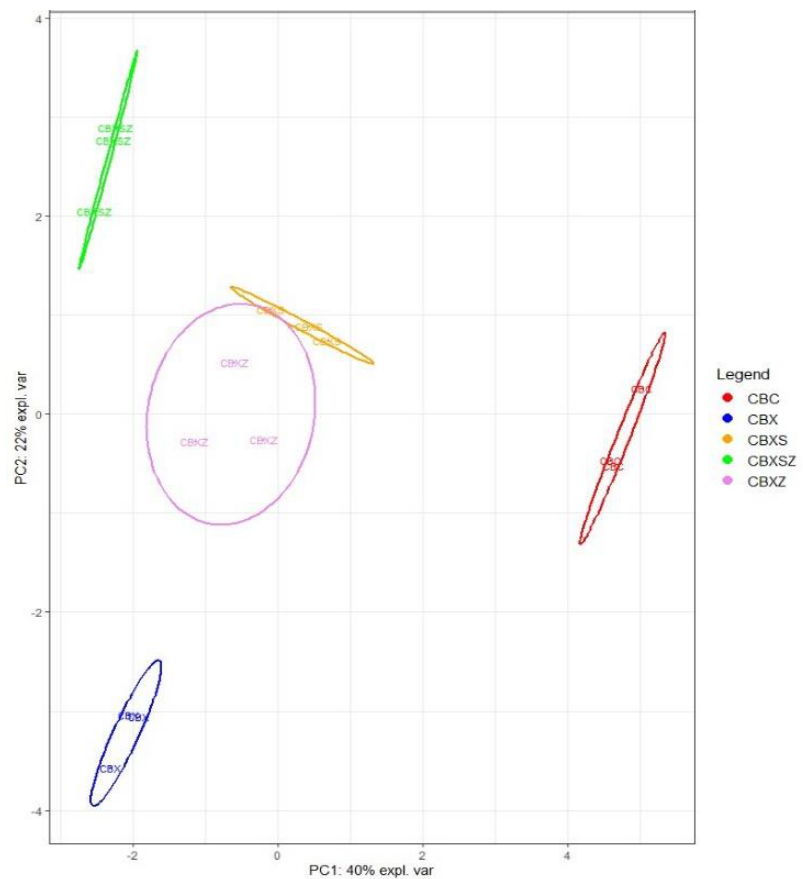
Figure 10. Principal component analysis (PCA) biplot with ellipses (confidence interval of 0.95) showing the effect of S. montana EO, EO-Zein NP nanoformulation and empty zein NPs on infected tomato plants. PC1 (first axis) explained 40% of the variance, while the PC2 (second axis) explained 22% of the variance. CBC — Uninfected/Untreated; CBX — Infected/Untreated; CBXS — Infected/EO; CBXSZ — Infected/EO-Zein NPs; CBXZ — Infected/Zein NPs.